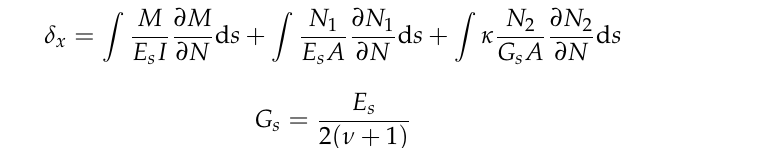
The equivalent elastic modulus in the x -direction is: